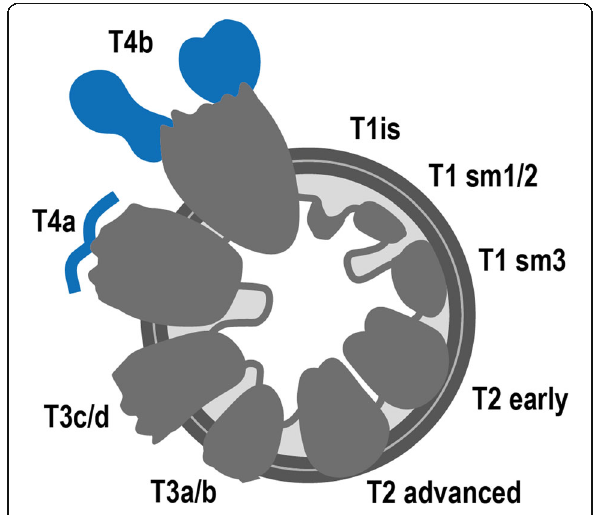
Fig. 11 T stages and substages. T1is: tumour in situ; T1sm1/2: tumour invades the submucosa, but not its full thickness; T1sm3: tumour invades the full thickness of the submucosa; T2 early: tumour focally invades the muscularis propria ; T2 advanced: tumour invades the full thickness of the muscularis propria ; T3a: tumour extends < 1 mm into the mesorectal fat; T3b: tumour extends between 1 and 5 mm into the mesorectal fat; T3c: tumour extends between 5 and 15 mm into the mesorectal fat; T3d: tumour extends > 15 mm into the mesorectal fat; T4a: tumour invades